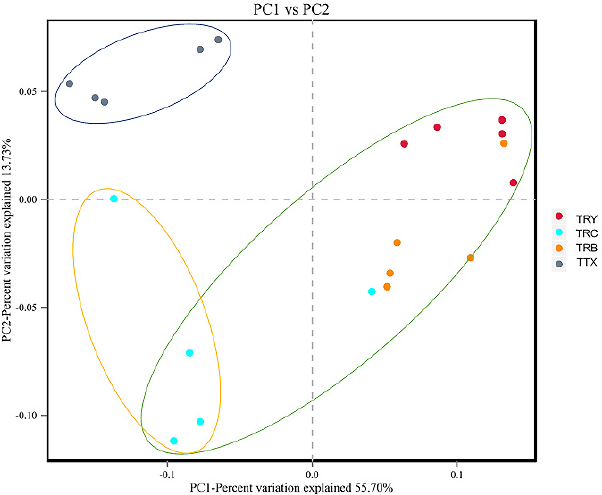
Figure 2. The principal coordinate analysis (PCoA) based on Bray-Curtis distance of rhizosphere microbiome in C. henryi.